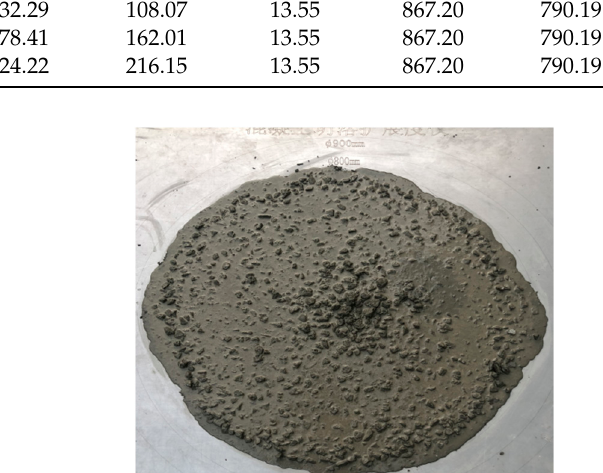
Figure 4. The molecular formula of polycarboxylic acid.